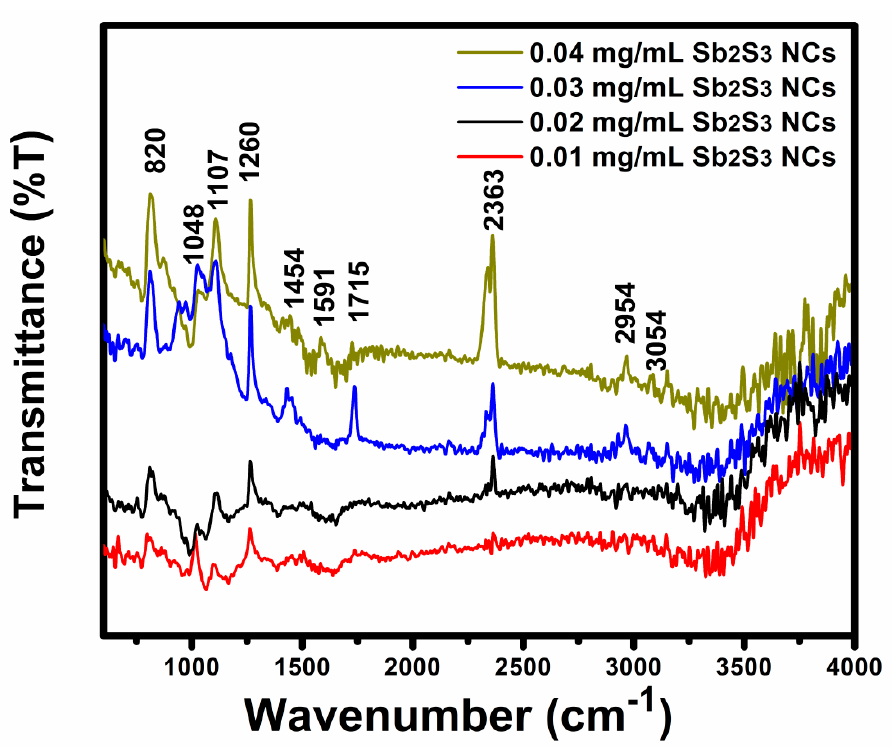
Figure 9. FTIR spectra of the P 3 HT:PCBM:Sb 2 S 3 NC blended films with different Sb 2 S 3 NC concen- trations.